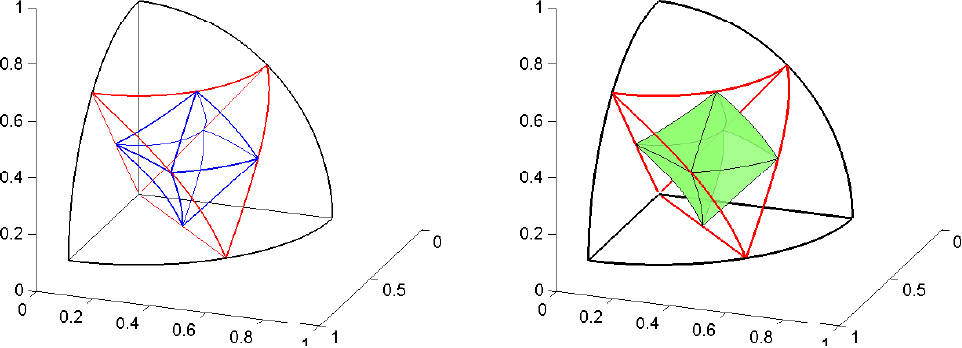
Figure 9. Left: the image on the ball of the positive octant; Right: the same image rotated.